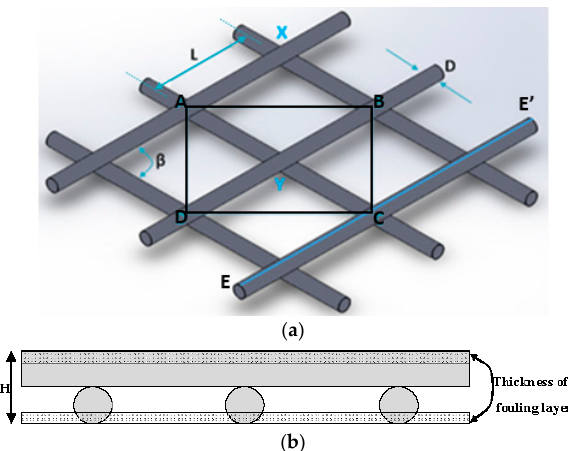
Figure 1. ( a ) The basic geometry of the feed-spacer considered, indicating the 3D unit cells, and the computational domain ABCD; ( b ) a cross-sectional view of the spacer-filled flow channel, along the EE’ plane, with filament crossing angle β = 90°, and fouling layers of thickness h , reducing the channel gap H .